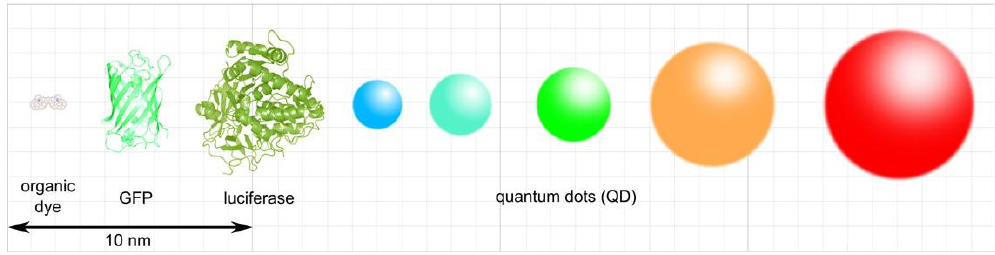
Figure 2. Relative sizes of different fluorophores. Coordinates for spatial structures of GFP and firefly luciferase were obtained from PDB 1EMA and 1LCI, respectively. Figure adapted from [37]. A palette of blue-shifted versions (e.g., ECFP and Cerulean) and yellow-shifted versions (e.g.,